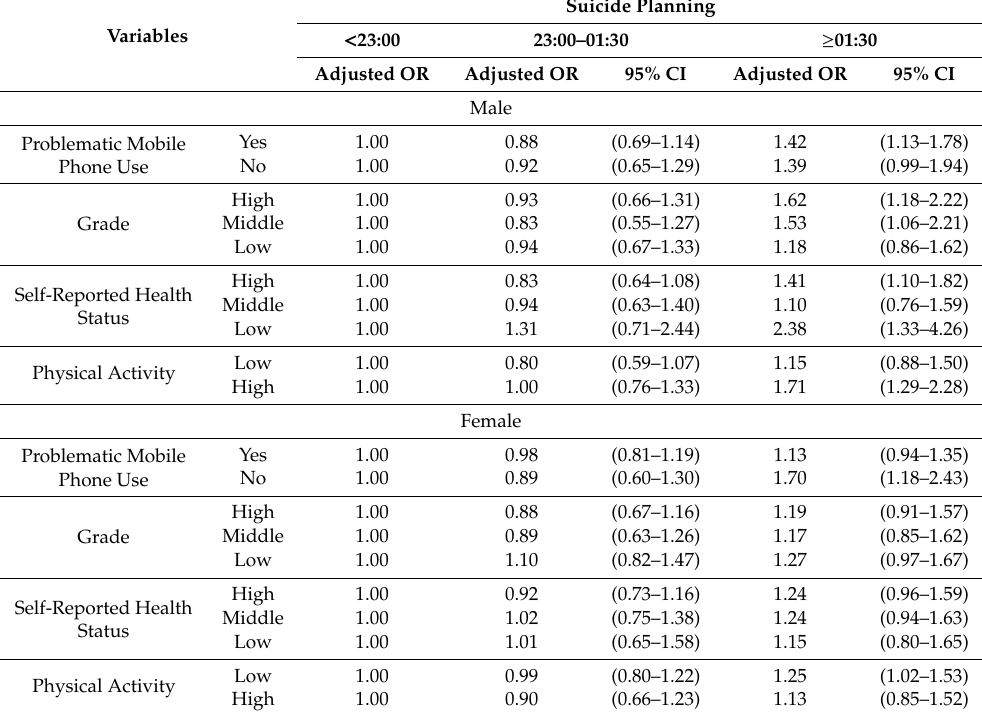
Table 3. Subgroup analysis of the association of bedtime with suicide planning, stratified by